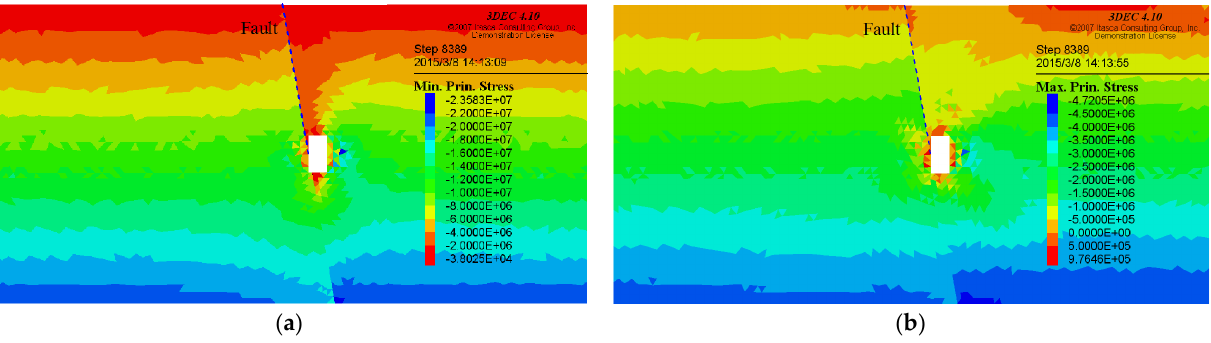
Figure 14. Stress field distribution of surrounding rock on the fault plane when the fault dip angle of 80°, they should be listed as: ( a ) Maximum principal stress distribution; ( b ) Minimum principal stress distribution.